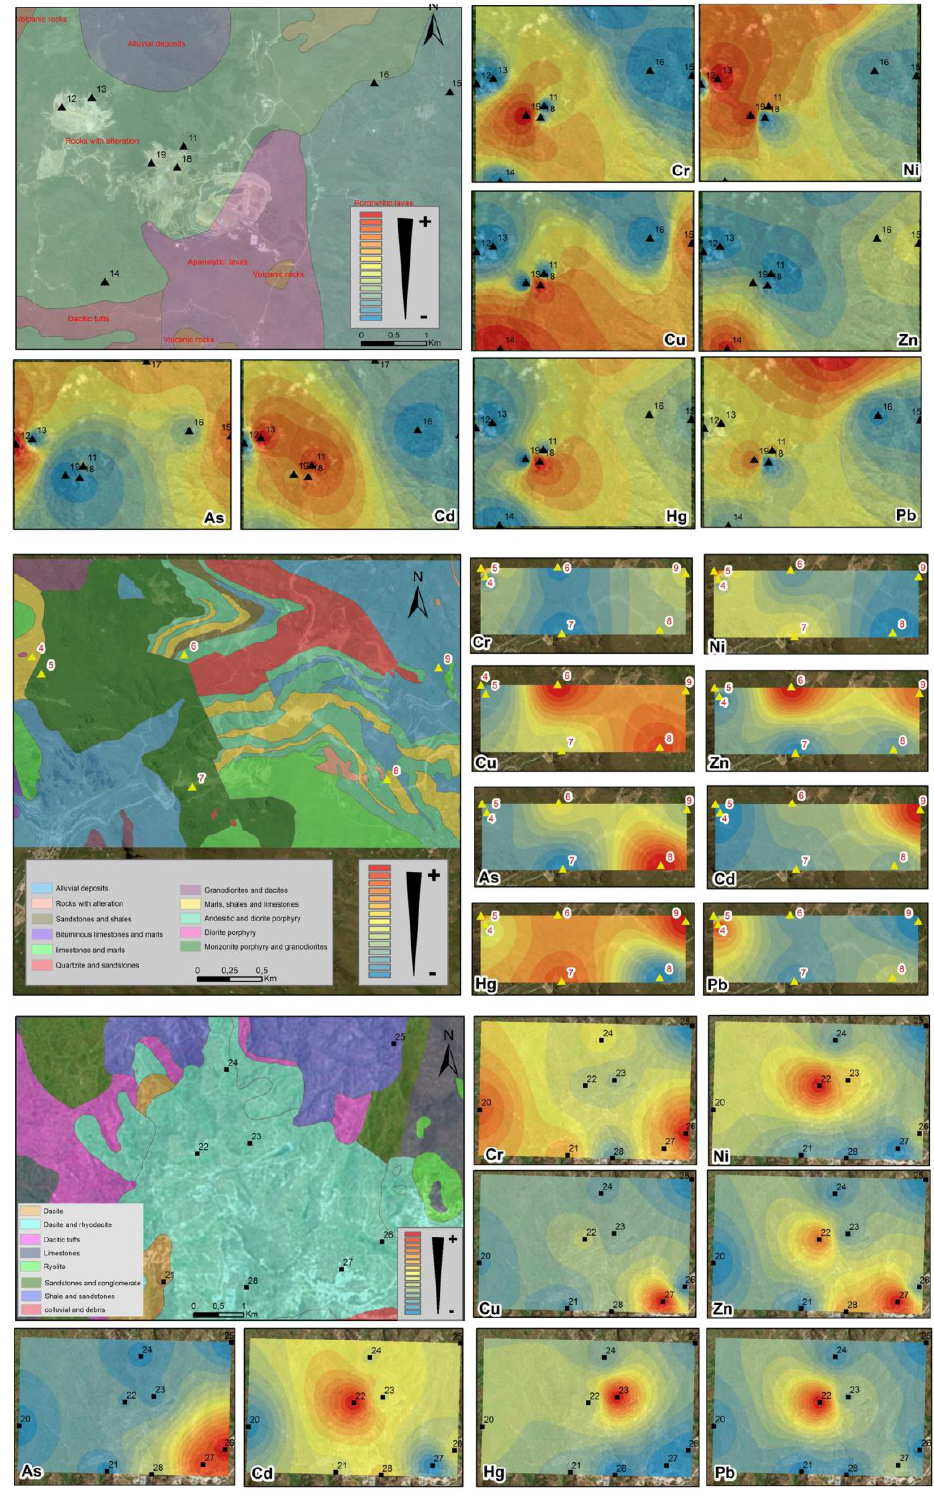
Figure 5. Lithological map-sampling points (soil profiles) and spatial distribution of heavy metals in soils of the Zanja (top), Colquirrumi (middle) and Julcani (bottom).